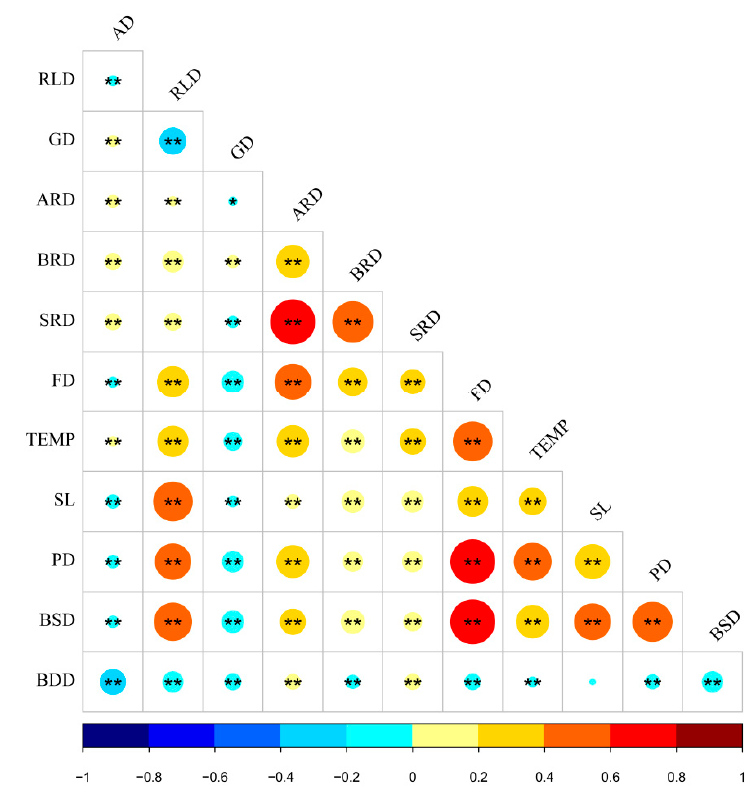
Figure 6. Correlation test of footpath environment elements. Note: “ − 1 to 1” represents the range of correlation path coefficient values; The size of the circle represents the size of the path coefficient value; “**” indicates p < 0.01, “*” indicates p < 0.05. Table 4. Multiple linear regression analysis and multicollinearity test of footpath environment and residents’ JA.